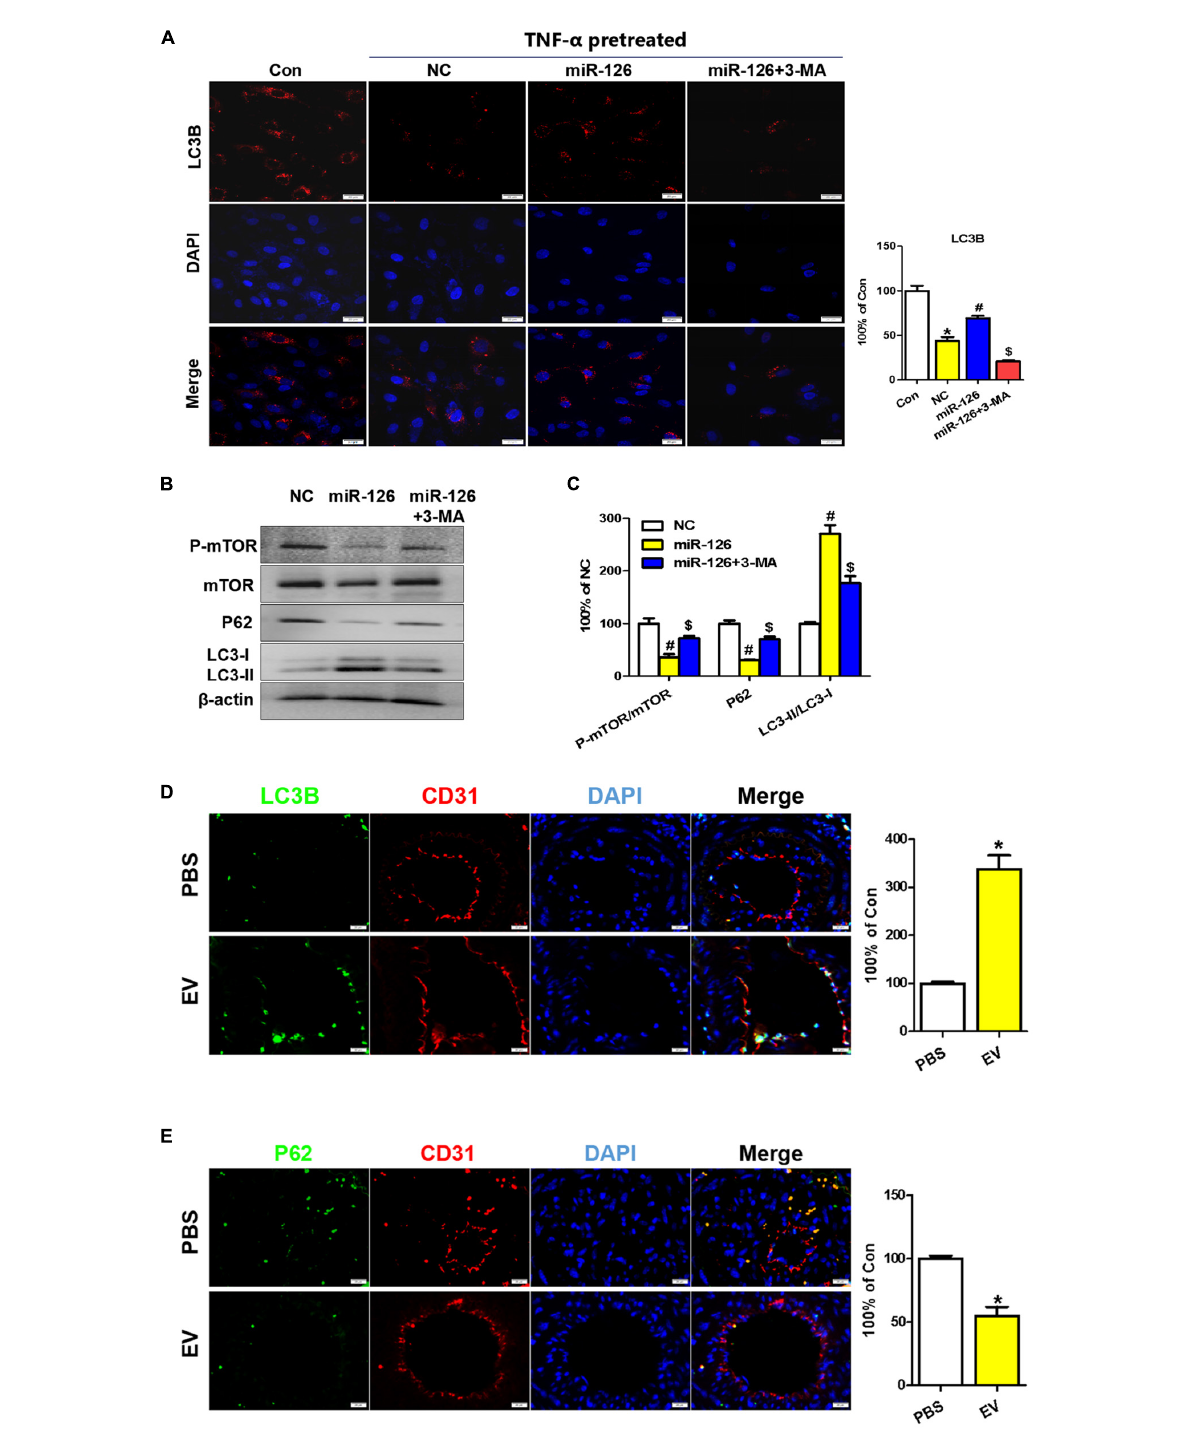
FIGURE7 Upregulation of autophagy in EC of the carotid artery upon human-induced pluripotent stem cell- endothelial cell-extracellular vesicle (hiPSC-EC-EV) treatment. (A) LC3B staining in human umbilical vein endothelial cells (HUVECs) following treatment with or without EV and 3-MA in the presence of TNF- α and quantification of the LC3B-positive signals. (B) Western blotting analysis of the p-mTOR, mTOR, P62, and LC3 proteins in the treated and untreated HUVECs. (C) Densitometric quantification proteins from the Western blotting image pane in panel (B) . * p < 0.05 vs. Con; # p < 0.05 vs. NC; $ p < 0.05 vs. miR-126. (D,E) Immunofluorescence staining of ECs for LC3B (D) and P62 (E) markers and their quantification (bar charts) in mouse carotid artery sections. Data represent mean ± SD from three independent experiments ( n = 3). Differences between linked groups were evaluated by a two-tailed Student’s t -test. * p < 0.05 vs.